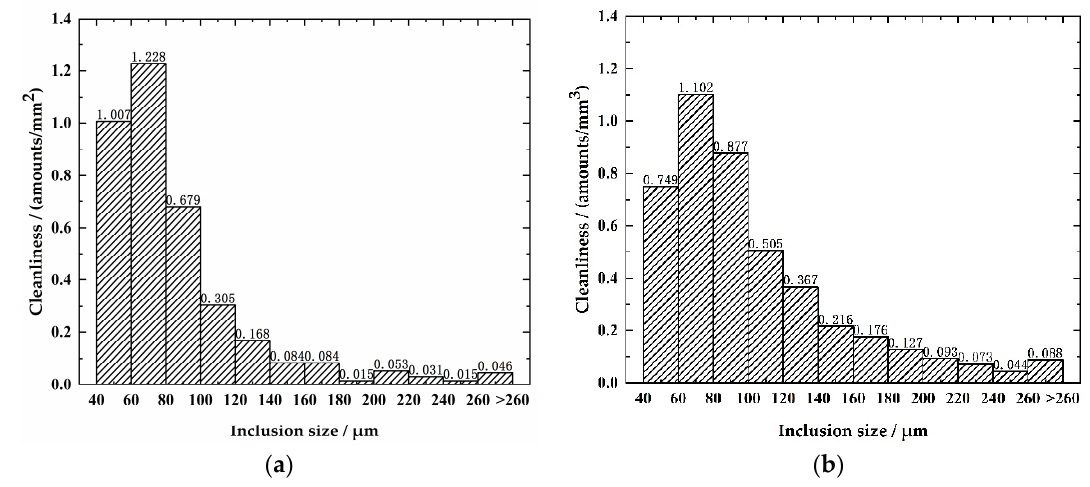
Figure 12. Histogram of size distribution of inclusions obtained by different methods. ( a ) distribution of inclusions of different sizes by LSCM; ( b ) distribution of inclusions of different sizes by ultrasonic microscope.